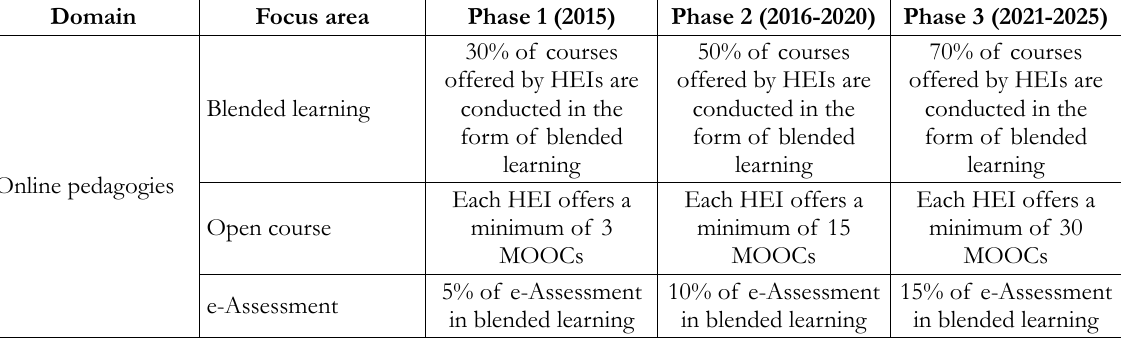
Table 2. The milestone for Domain 3: Online Pedagogies in DePAN 2.0 (Department of Higher Education, n.d.)